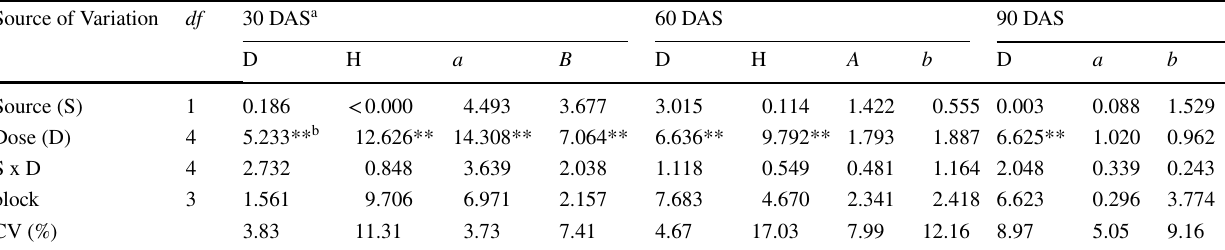
Table 4 ANOVA for soybean stem diameter (D—mm), plant height (H—m) and chlorophylls a and b to compare sources (without additional treatments) and doses